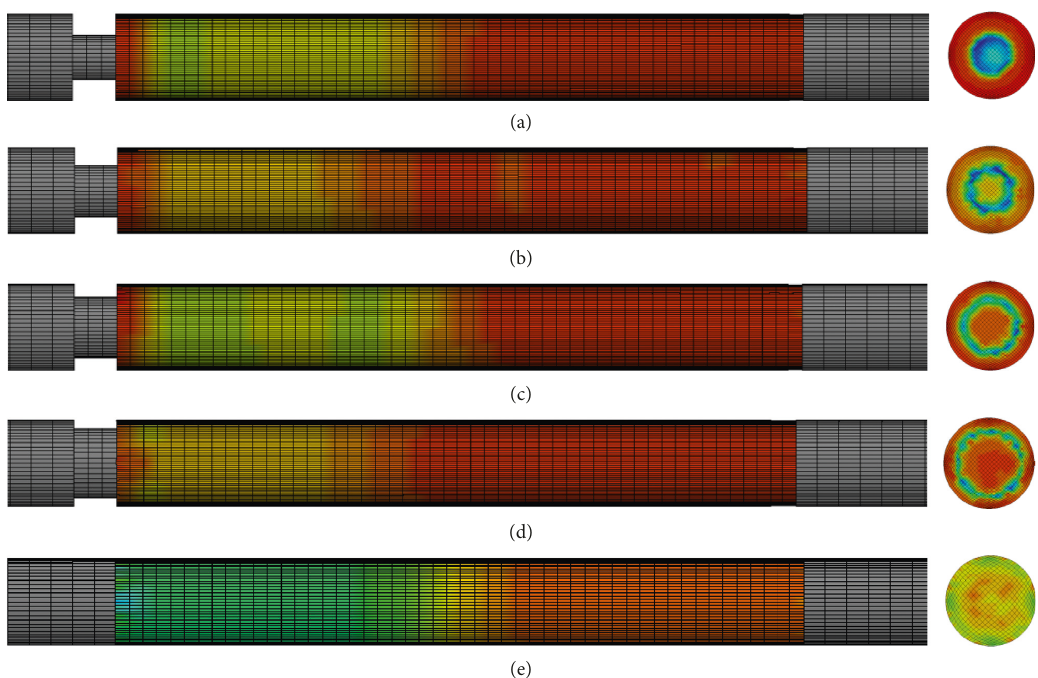
Figure 12: Energy scattering in the numerical simulations: (a) Φ 1. (b) Φ 2. (c) Φ 3. (d) Φ 4. (e) Φ